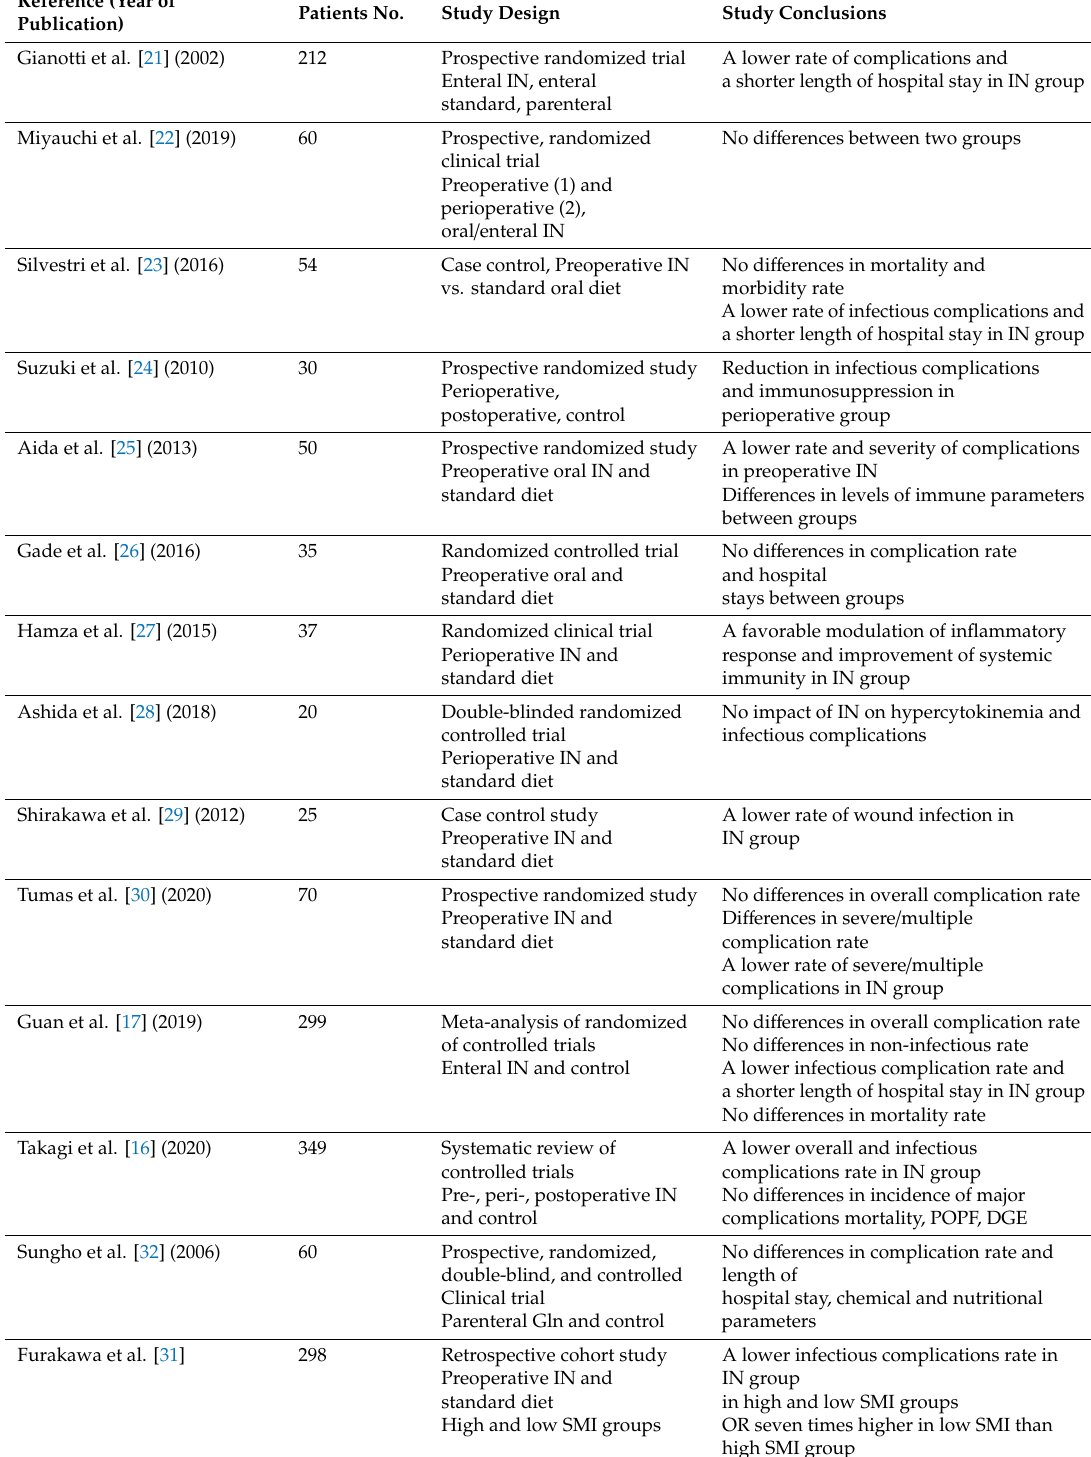
Table 2. Summary of Studies on Immunonutrition in